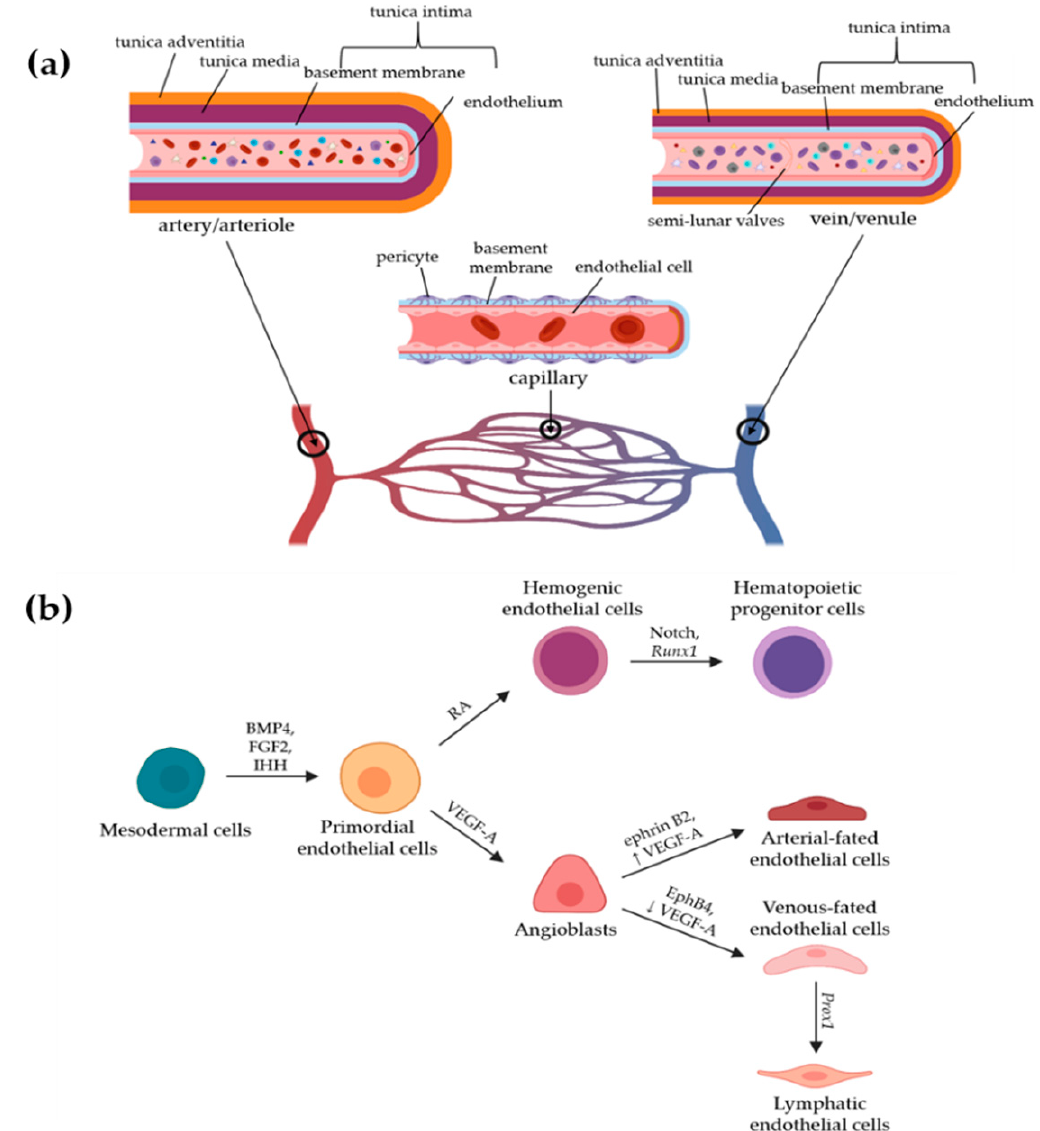
Figure 1. ( a ) The distinct structures and general functions of the three main types of blood vessels: arteries / arterioles, capillaries, and veins / venules; ( b ) The di ff erentiation pathway of the major cell types in the cardiovascular system as well as lymphatic endothelial cells (ECs). The mesoderm is the source of the precursor vessel cells and hematopoietic progenitor cells. From there, precursor vessel cells di ff erentiate into either arterial-fated or venous-fated ECs. In the lymphatic vasculature, venous-fated ECs further di ff erentiate into lymphatic ECs (LECs).